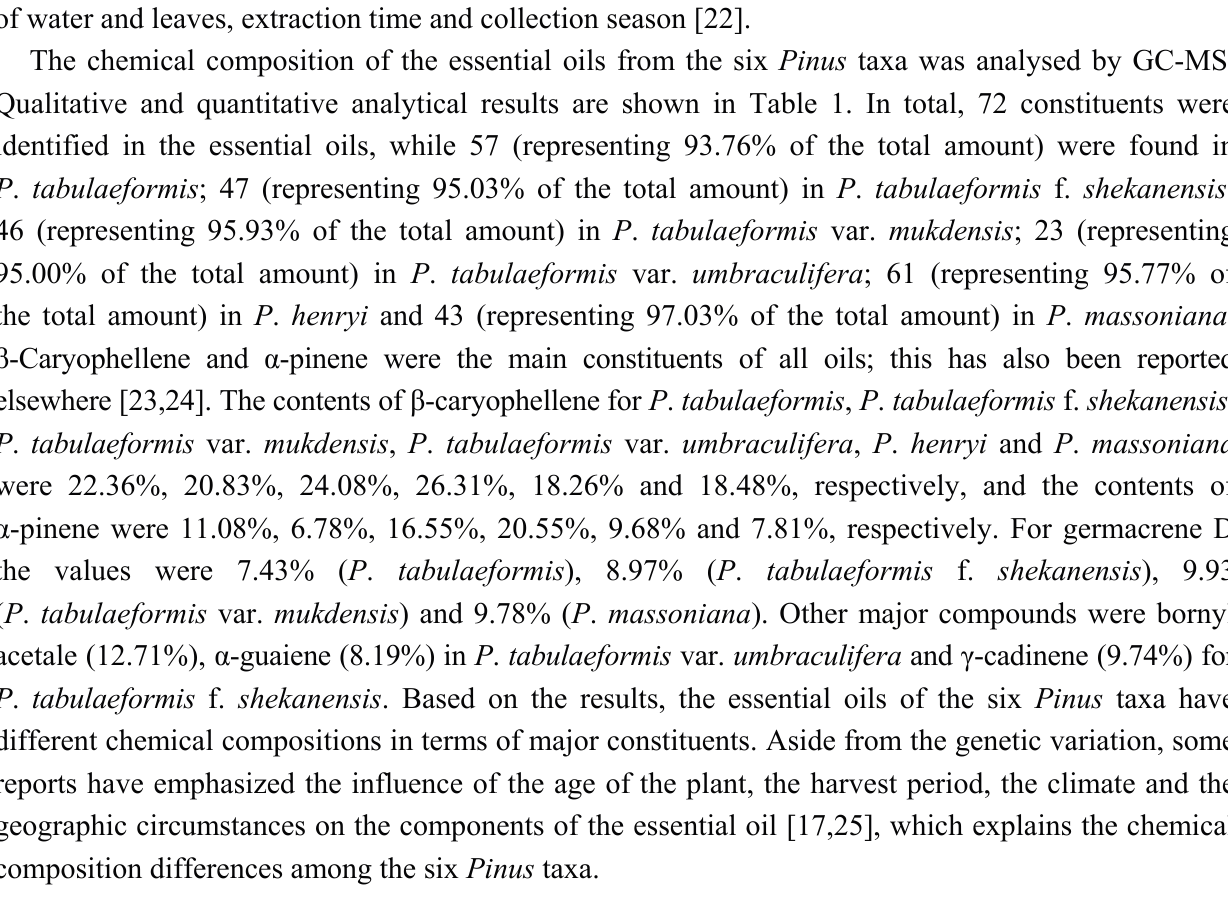
Table 1. Chemical composition of the essential oils of the six Pinus